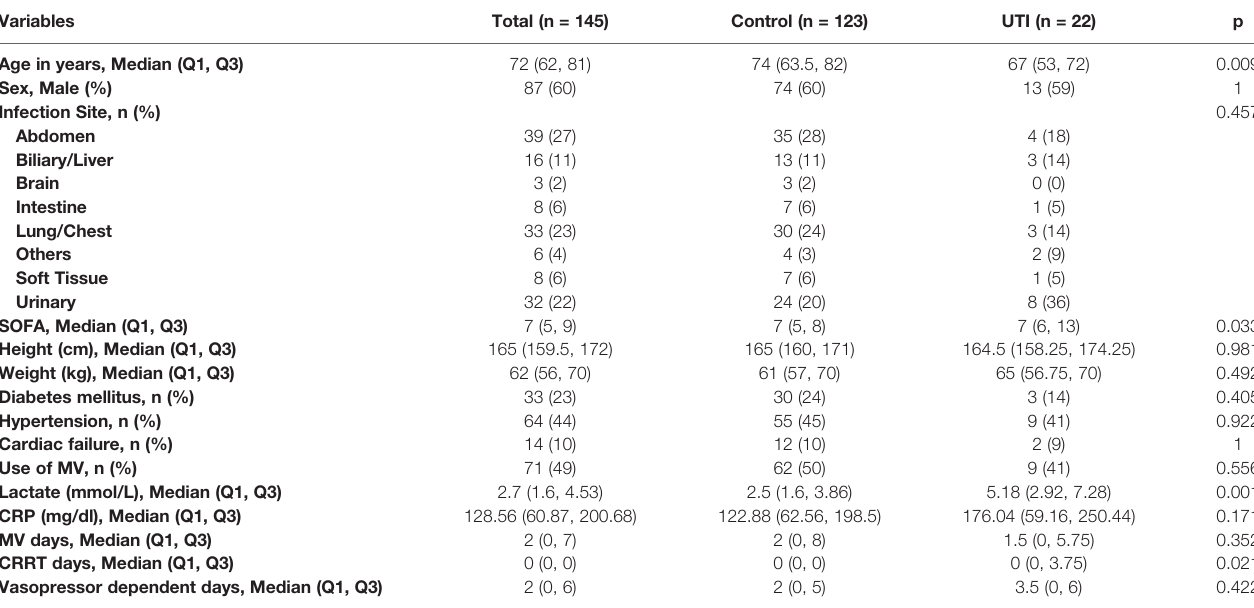
TABLE 1 | Baseline characteristics of the UTI and control groups.